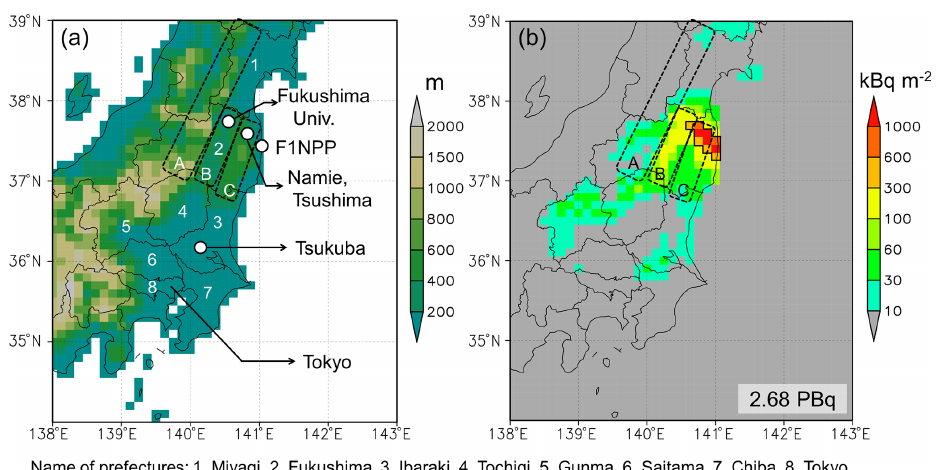
Figure 1. (a) Model domain ( (cid:49) longitude = 0.125 ◦ and (cid:49) latitude = 0.1 ◦ ), terrestrial elevations, major locations, and names of prefectures and geographical features. (b) Initial deposition amounts of 137 Cs measured by aircraft (NRA, 2012) and used as boundary conditions for the simulation. The decay correction for the observation was made for March–May 2012, depending on the regions. The area surrounded by the black solid line is defined as the resuspension source area ( > 300kBqm − 2 ) in the source–receptor analysis presented in Sect. 3.2. The total areal amount is embedded at the bottom right of the